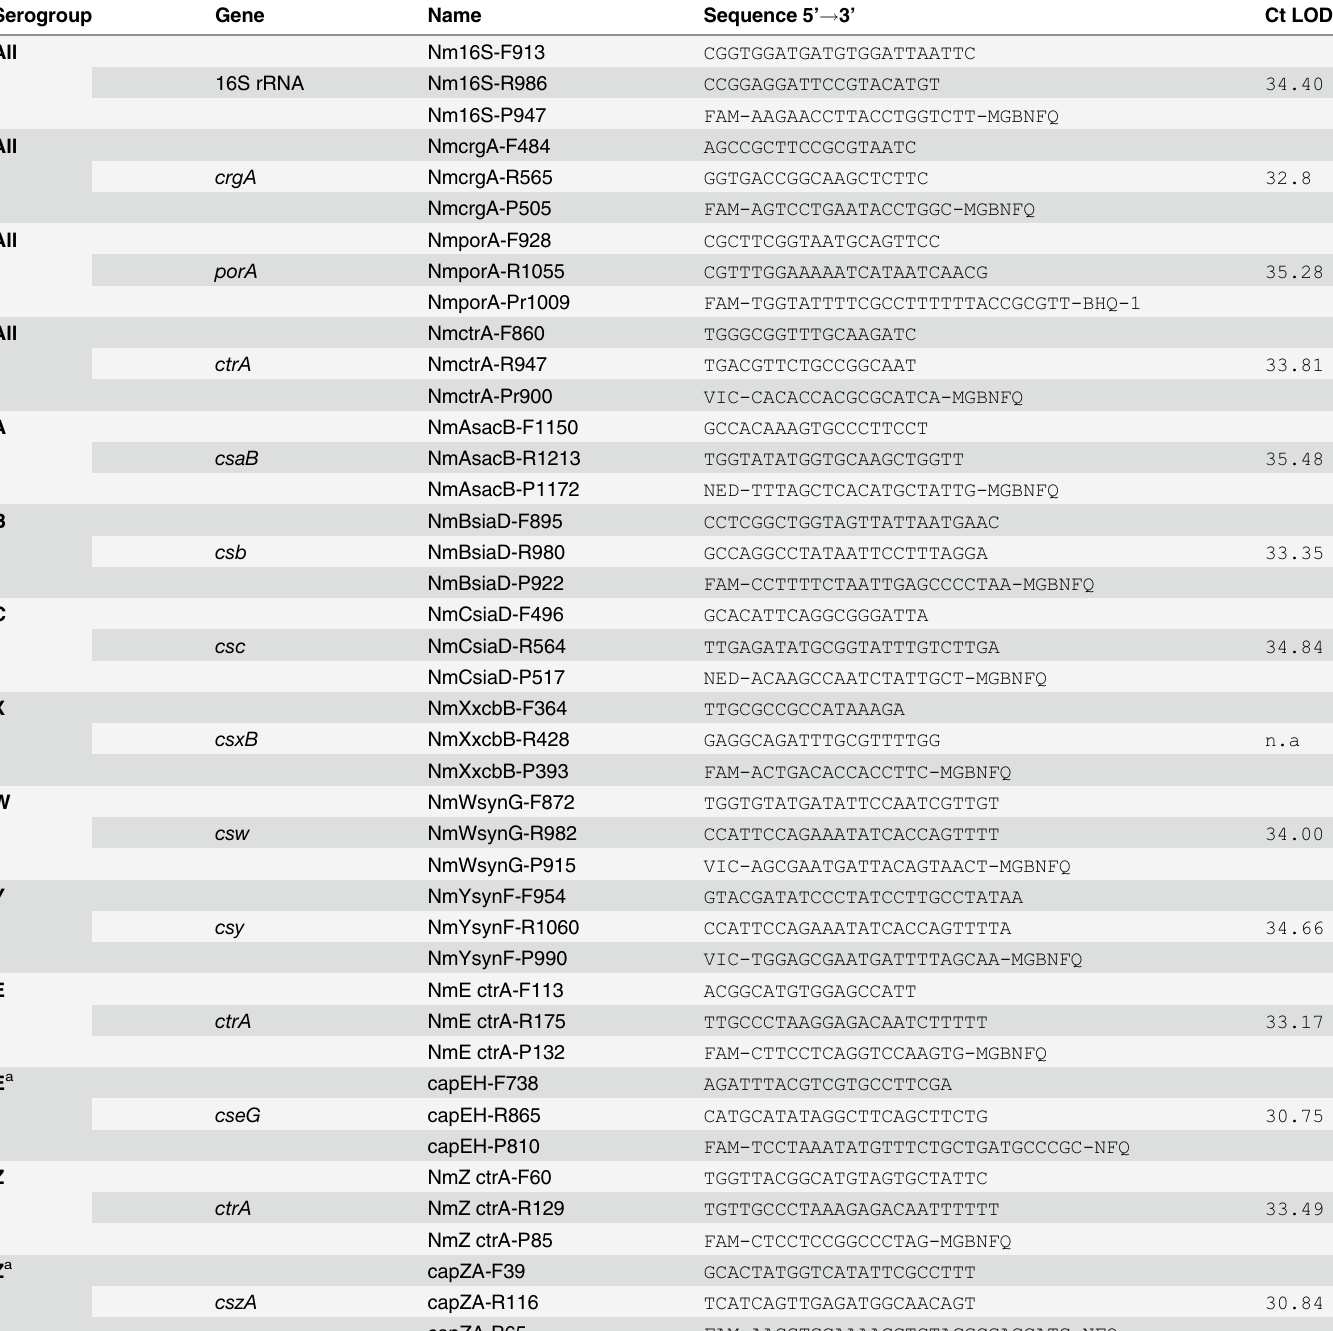
Table 1. Real-Time PCR Primers and Probes for Identification and Genogrouping N . meningitidis .